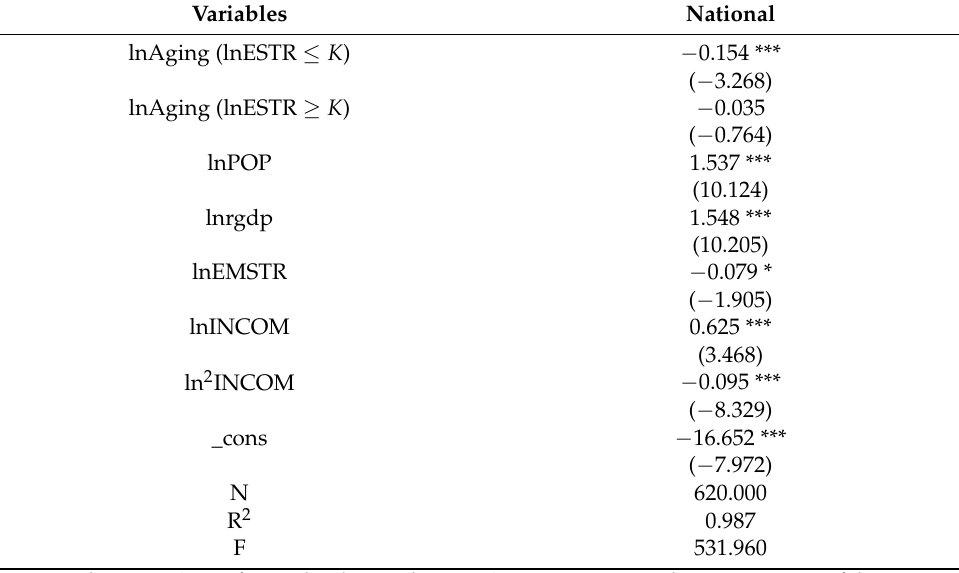
Table 9. Energy consumption structure threshold effect of population aging on carbon emissions.